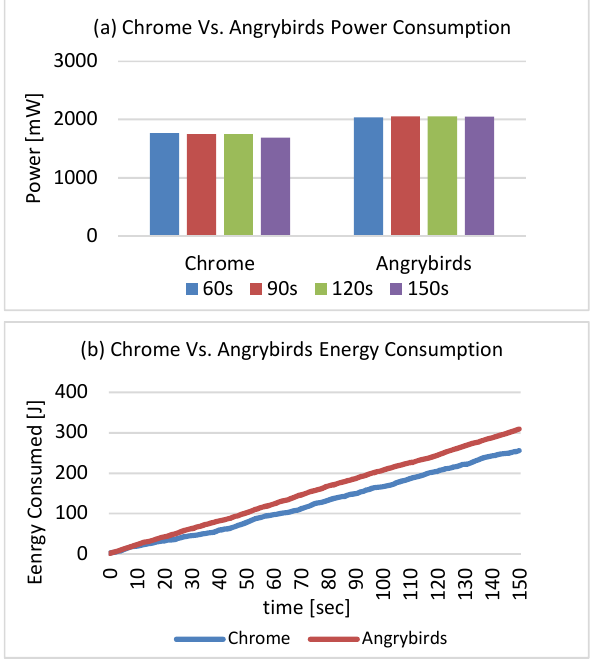
Figure 3. Power & energy consumption of Chrome & Angrybirds running on Nexus